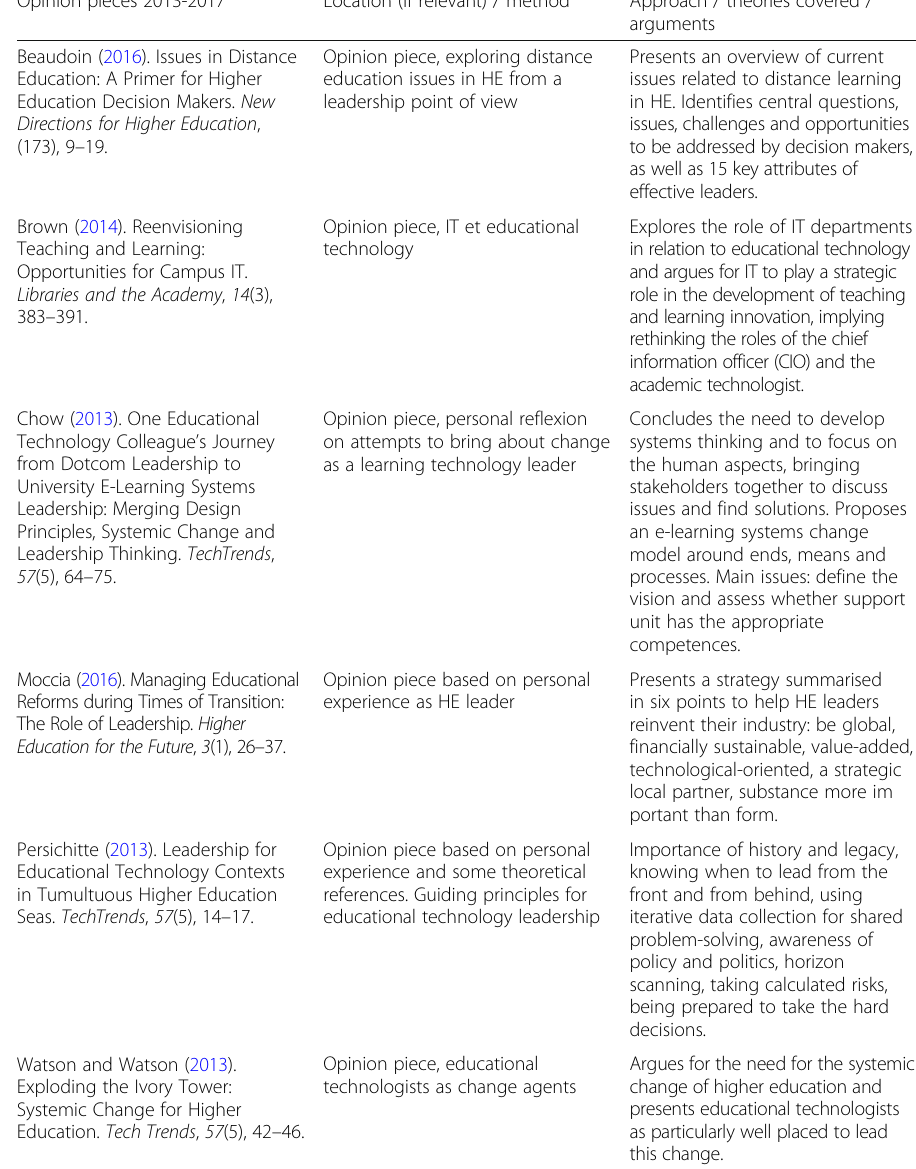
Table 4 Results: Opinion